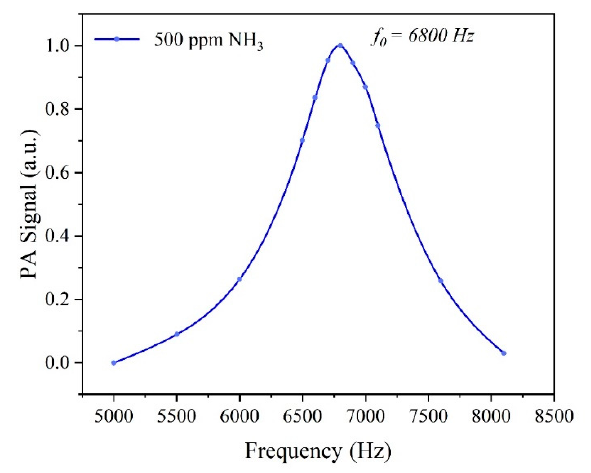
Figure 3. Frequency response curves of the PA cell with the first longitudinal resonance.